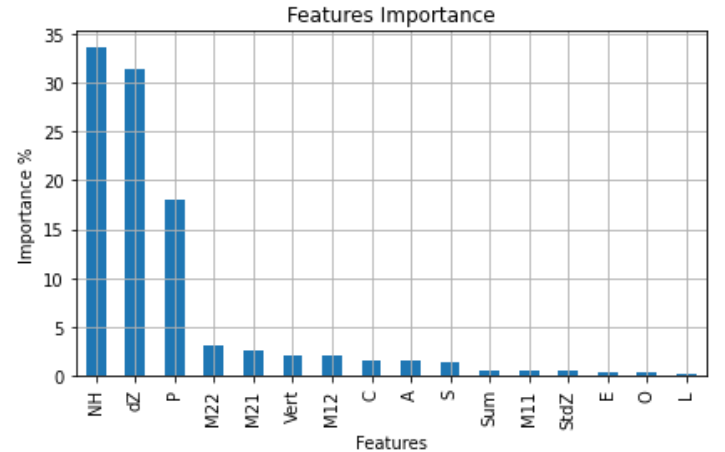
Figure 7. Features importance for of the sixteen features.